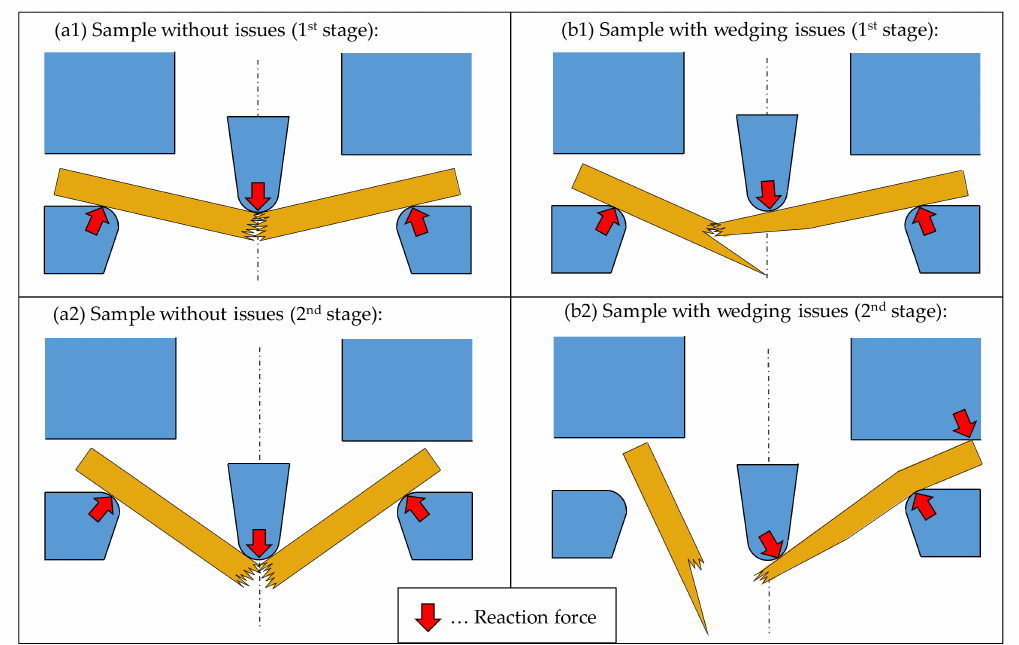
Figure 3. Comparison of the fracture behaviour between a sample without issues ( a1 , a2 ) and a sample with wedging issues ( b1 , b2